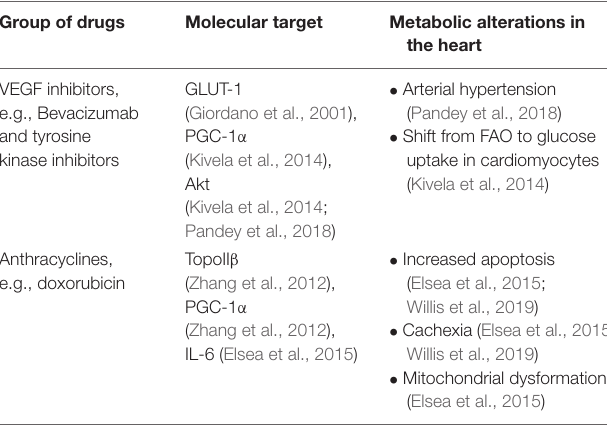
TABLE 3 | Cancer therapies which influence cardiac